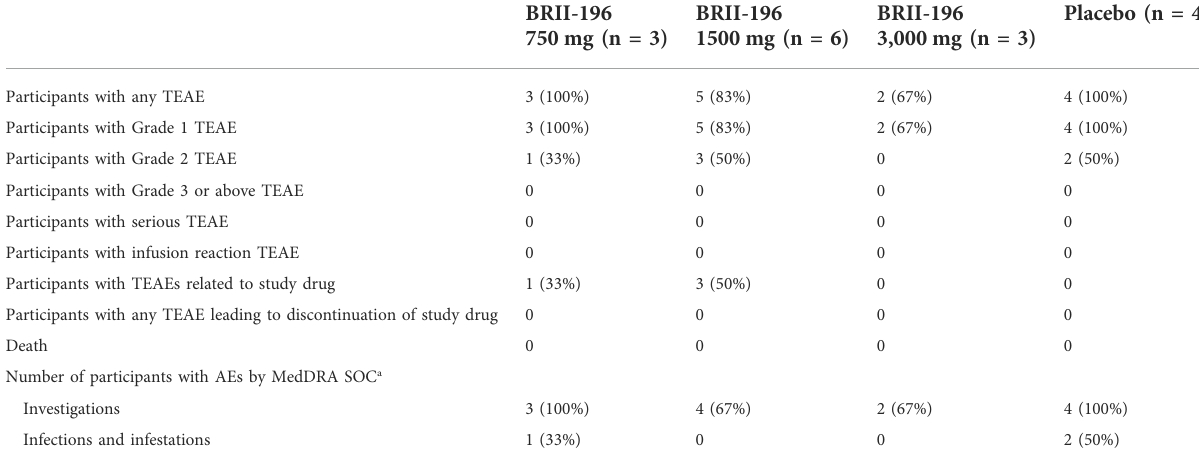
TABLE 2 Summary of adverse events of BRII-196-001 study.